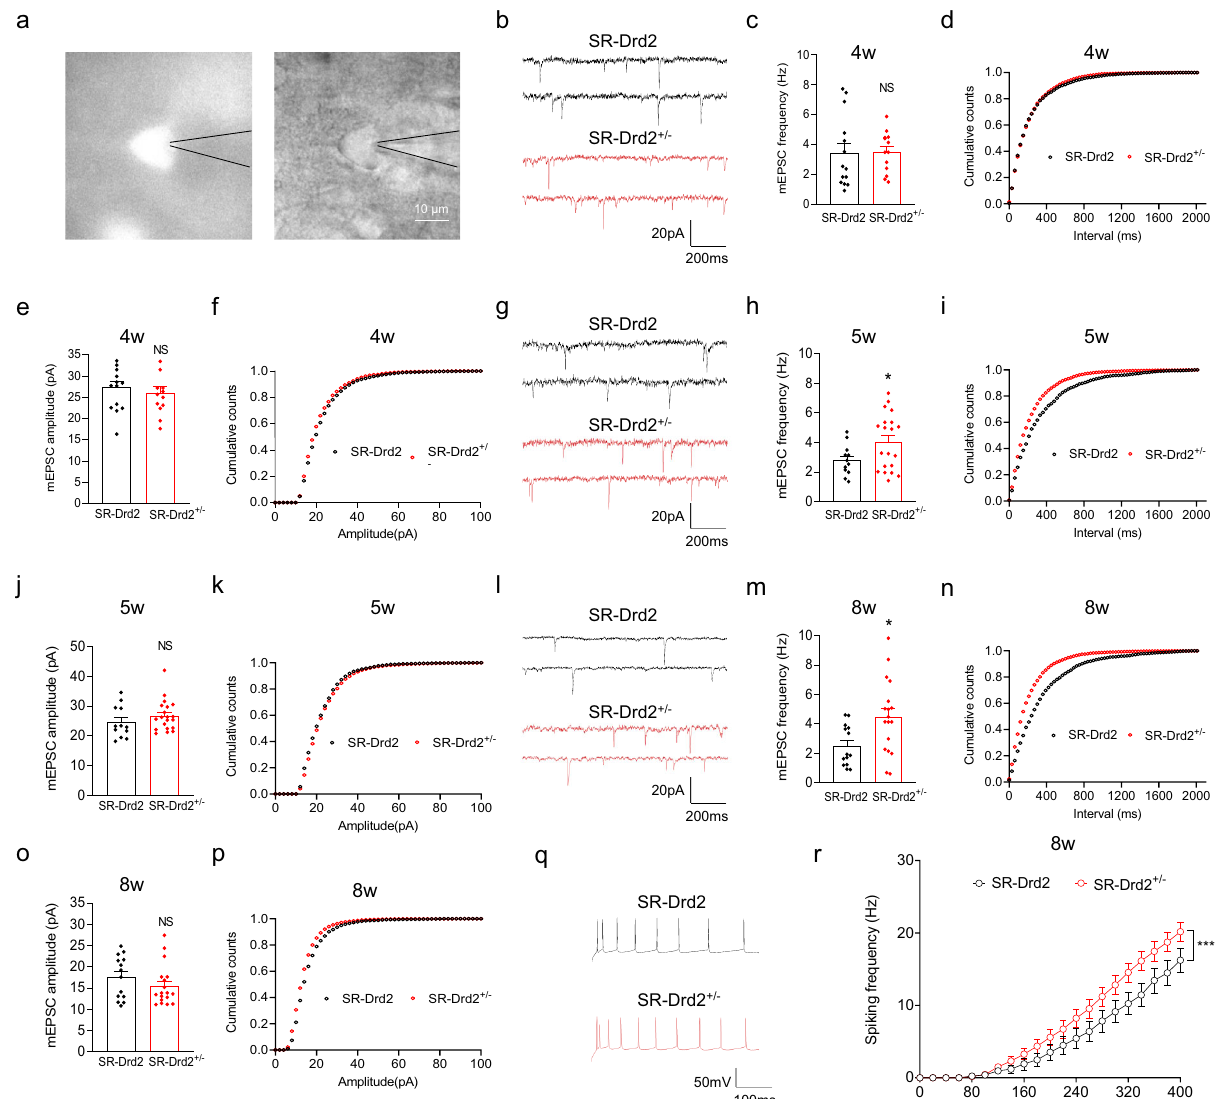
Fig. 3 Hyperglutamatergic function of Drd2-positive neurons in SR-Drd2 + / − rats. a Diagram to show the whole-cell recording of Drd2-positive neurons in layer 5 of ACC from SR-Drd2 rats. Left, the fl uorescent image, right, the phase-contrast image. Scale bar, 10 μ m. Three independent experiments were repeated to get similar results. b Representative mEPSC traces of Drd2-positive neurons from 4-week-old control and SR-Drd2 + / − rats. c Similar mEPSC frequency of Drd2-positive neurons between 4-week-old control and SR-Drd2 + / − rats. NS not signi fi cant, P = 0.9421, two-sided t -test, n = 14 neurons from 3 control rats, n = 13 neurons from 3 SR-Drd2 + / − rats. Data are presented as mean values ± SEM. d Cumulative plots of mEPSC frequency. e Similar mEPSC amplitude of Drd2-positive neurons between 4-week-old control and SR-Drd2 + / − rats. NS not signi fi cant, P = 0.5763, two-sided t -test, n = 14 neurons from 3 control rats, n = 13 neurons from 3 SR-Drd2 + / − rats. Data are presented as mean values± SEM. f Cumulative plots of mEPSC amplitude. g Representative mEPSC traces of Drd2-positive neurons from 5-week-old control and SR-Drd2 + / − rats. h Increased mEPSC frequency of Drd2-positive neurons in 5-week-old SR-Drd2 + / − rats. * P = 0.0435, two-sided t -test, n = 12 neurons from 3 control rats, n = 20 neurons from 4 SR-Drd2 + / − rats. Data are presented as mean values ± SEM. i Cumulative plots of mEPSC frequency. j Similar mEPSC amplitude of Drd2-positive neurons between 5-week-old control and SR-Drd2 + / − rats. NS not signi fi cant, P = 0.263, two-sided t -test, n = 12 neurons from 3 control rats, n = 20 neurons from 4 SR-Drd2 + / − rats. Data are presented as mean values± SEM. k Cumulative plots of mEPSC amplitude. l Representative mEPSC traces of Drd2-positive neurons from 8-week- old control and SR-Drd2 + / − rats. m Increased mEPSC frequency of Drd2-positive neurons in 8-week-old SR-Drd2 + / − rats. * P = 0.0139, two-sided t -test, n = 14 neurons from 3 control rats, n = 18 neurons from 4 SR-Drd2 + / − rats. Data are presented as mean values ± SEM. n Cumulative plots of mEPSC frequency. o Similar mEPSC amplitude of Drd2-positive neurons between 8-week-old control and SR-Drd2 + / − rats. NS not signi fi cant, P = 0.2503, two- sided t -test, n = 14 neurons from 3 control rats, n = 18 neurons from 4 SR-Drd2 + / − rats. Data are presented as mean values ± SEM. p Cumulative plots of mEPSC amplitude. q Representative action potentials of Drd2-positive neurons from 8-week-old control and SR-Drd2 + / − rats. r Increased excitability of Drd2-positive neurons in 8-week-old SR-Drd2 + / − rats, compared with control rats. Shown are the I/O curves of action potentials from Drd2-positive neurons. *** Genotype F (1, 2010) = 57.55, P < 0.0001, two-way ANOVA, n = 25 neurons from 5 control rats, n = 44 neurons from 7 SR-Drd2 + / − rats. Data are presented as mean values ±